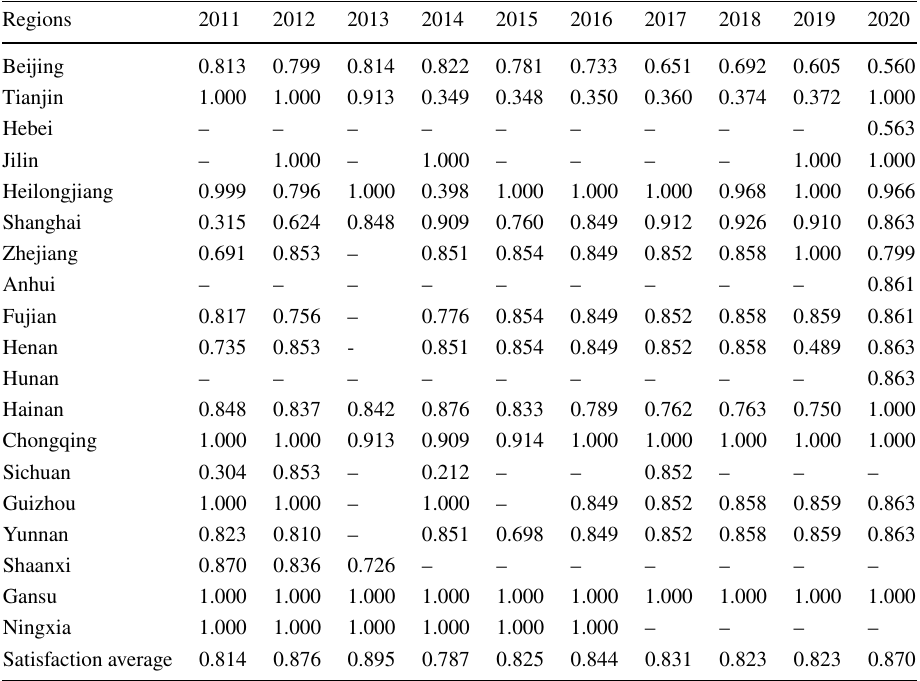
Table 12 Satisfaction of cross- efficiency by region from 2011 to